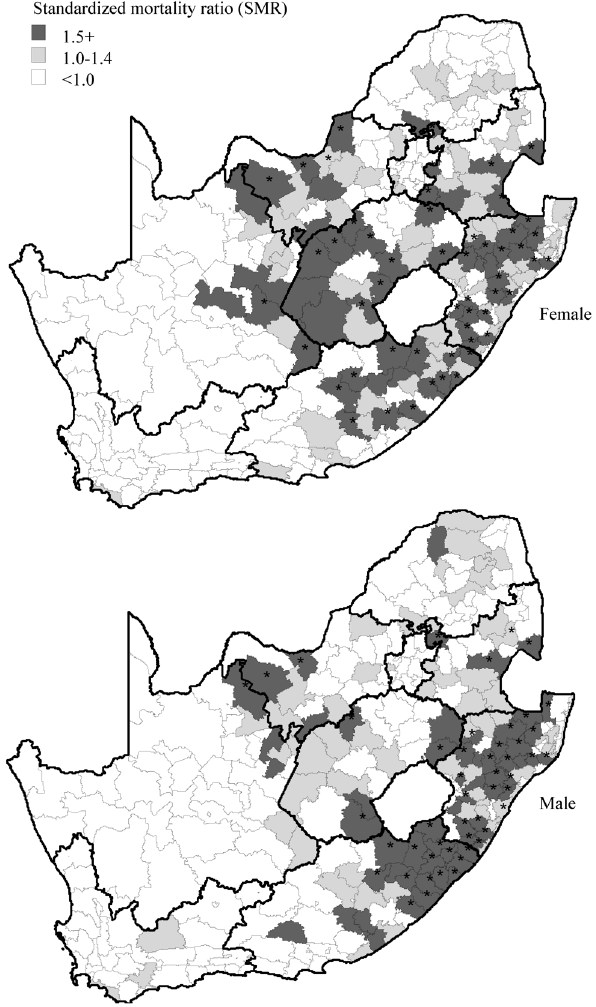
Figure 4. Adult mortality risk by gender at the quaternary (local municipality) level, South Africa, 2007. Districts with significant excess risk (p , 0.05) are highlighted (*).